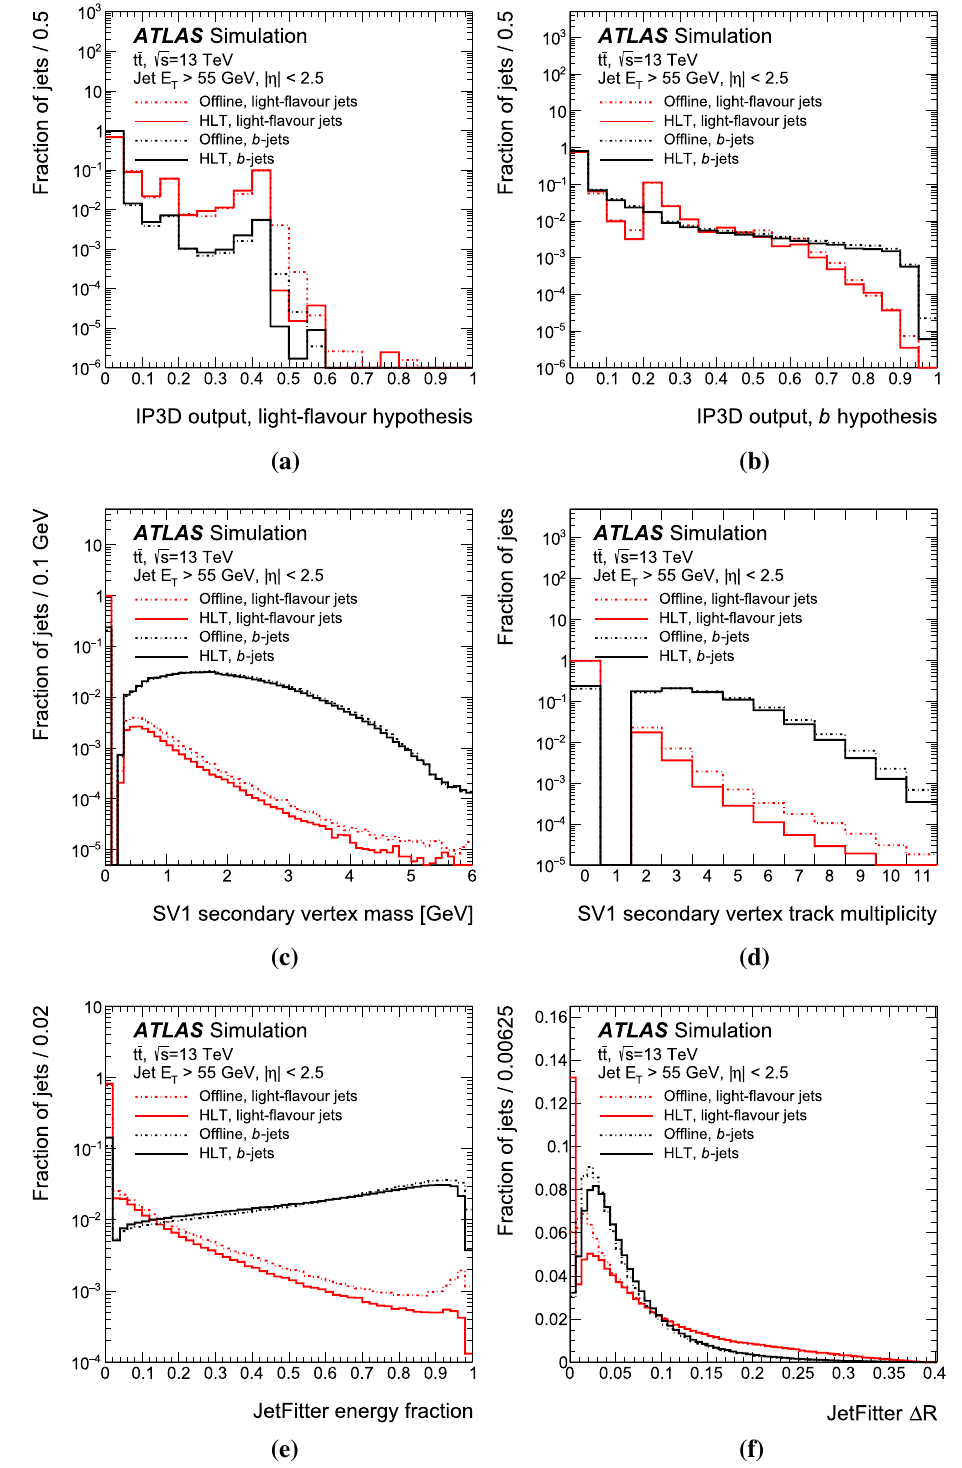
Fig. 9 Selected variables related to the IP3D (top row), SV1 (mid- dle row), and JetFitter (bottom row) algorithms. The distributions are shown for both b -jets and light-flavour jets, and when computed using HLT and offline quantities. The distributions show the probability for a jet to originate from a a light-flavour quark and b a b -quark, as com- puted by the IP3D algorithm, c the mass of the jet associated with the